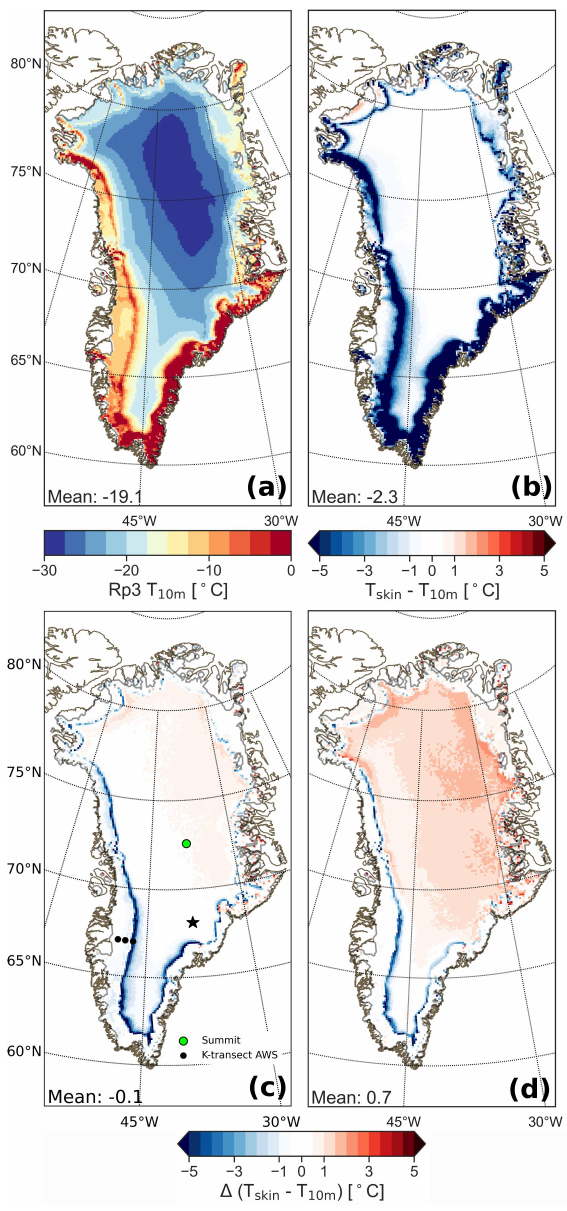
Figure 5. (a) Temperature at 10m depth ( T 10m ) at the end of the simulation (31 December 2015) for Rp3; (b) averaged yearly mean (2006–2015) skin temperature ( T skin ) difference with T 10m for Rp3, with positive values indicating that T skin is larger than T 10m ; (c) difference between Rp3 and Rp2 for T skin − T 10m . The dots in the southwest are the locations of the K-transect AWS sta- tions, from left to right: S6, S9, and S10. KAN-U and KAN-M of the PROMICE data set are located close to S10 and between S6 and S9, respectively, but are not shown separately. Subsurface tempera- ture profiles are available for Summit (green dot). The star indicates a location that is discussed in Sect. 4.1. (d) The difference between Rp3 WIE and Rp2 for T skin − T 10m . In panels (c) and (d) , a positive value indicates that the T skin − T 10m has become larger compared to